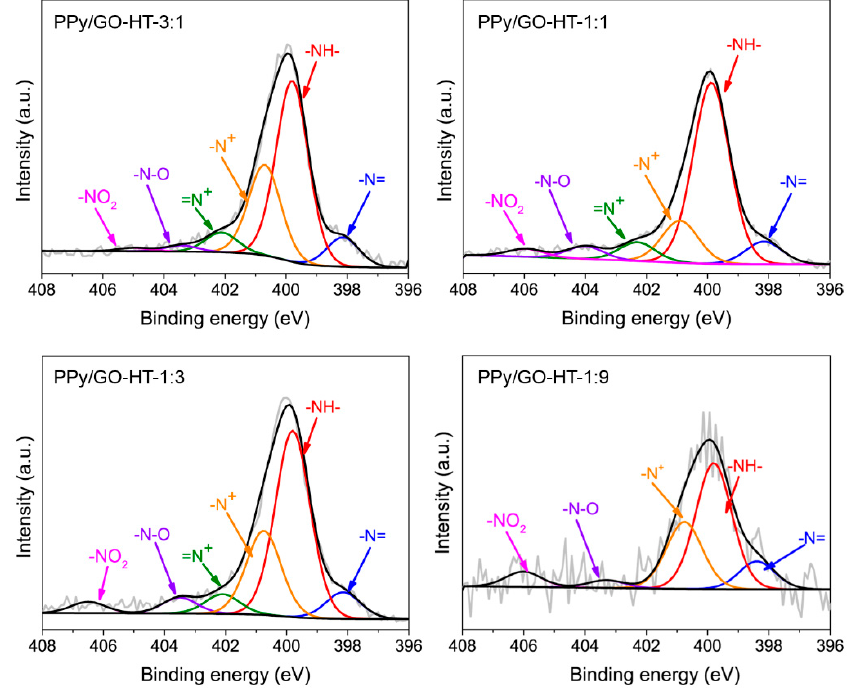
Figure 4. N1s high-resolution spectra of the PPy / GO-HT hybrids with di ff erent component mass ratios.